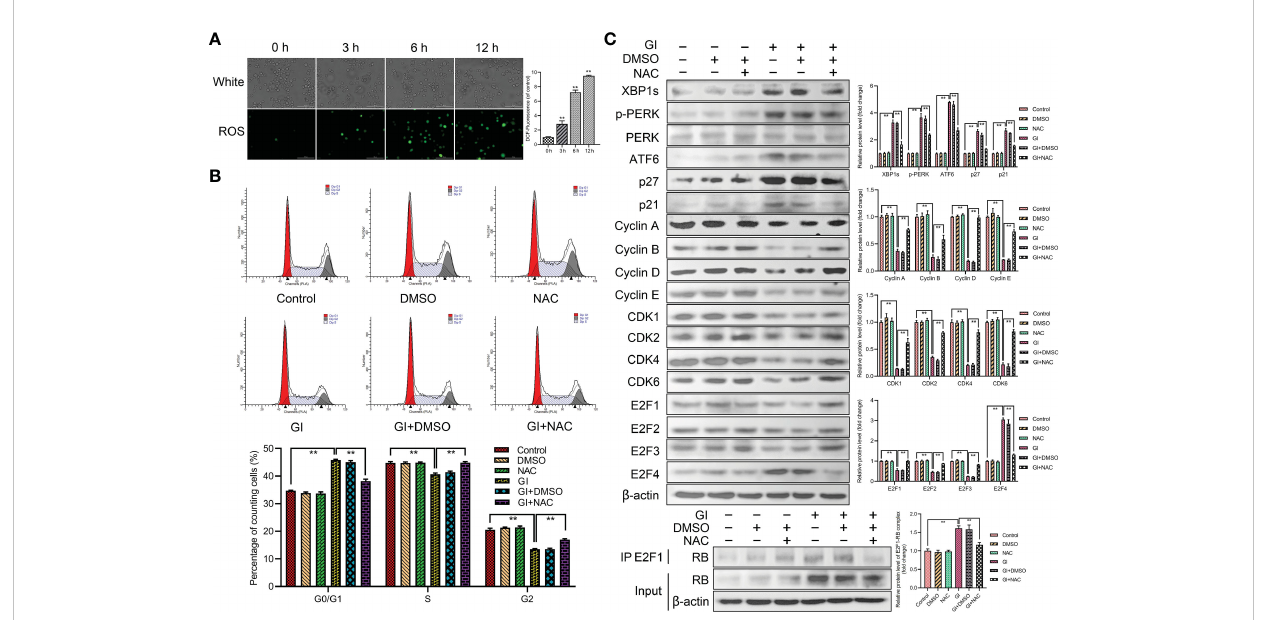
FIGURE 6 Host cell cycle arrest induced by Giardia via ROS ‐ mediated ER stress. (A) The ROS assay kit was used to measure ROS generation in Caco-2 cells with Giardia exposure for 0, 3, 6, 12 h (n = 3 wells/group, scale bar = 100 m m). Under treatment of the combination of Giardia with ROS inhibitor NAC in Caco-2 cells, (B) cell cycle distribution was detected by fl ow cytometry, (C) the expressions of UPR-related proteins, p21, p27, cyclins, CDKs and E2Fs were detected by western blotting, and formation of E2F1-RB complex was detected by co-IP. The results of western blot analyses (n = 3) were normalized against the level of b -actin. All experiments were repeated at least three times. Data were presented as mean ± SD. * p < 0.05, ** p < 0.01 versus relative control group. (A – C) Representative pictures are shown. G0/G1, S, and G2 indicate the different phases of the cell cycle. Gl, Giardia